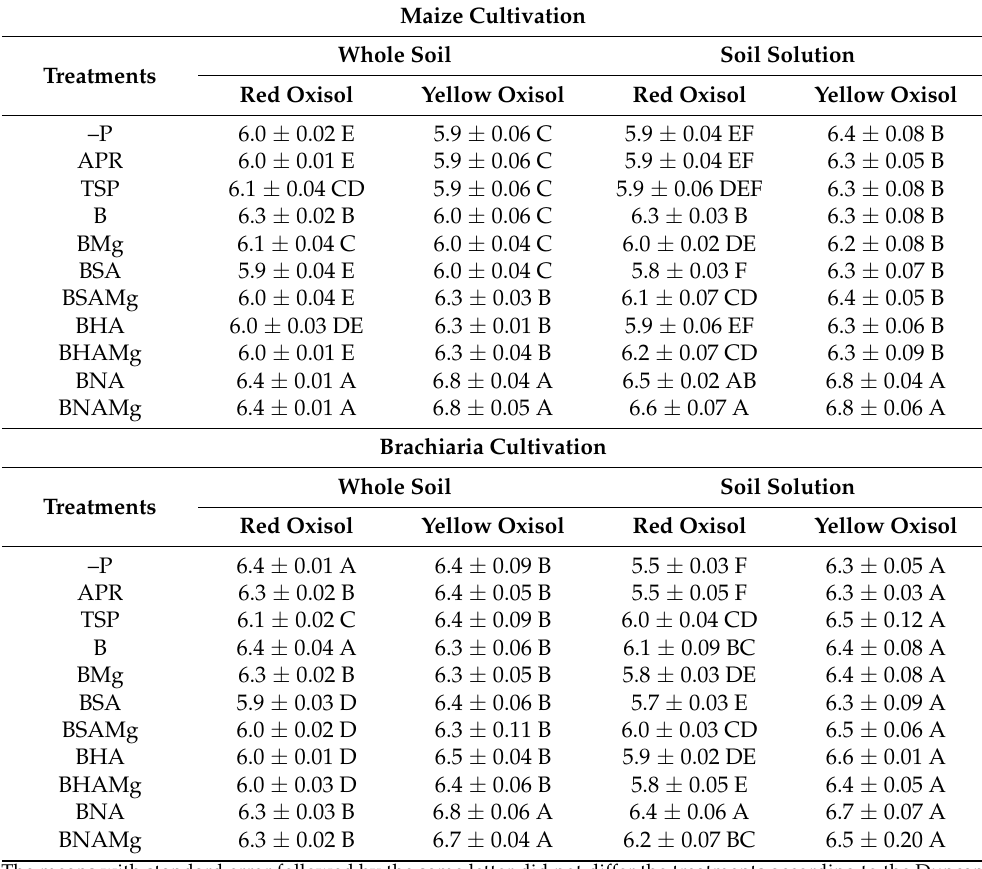
Table A5. pH of whole soil and its solution for maize and brachiaria grown in Red and Yellow Oxisols. Maize Cultivation